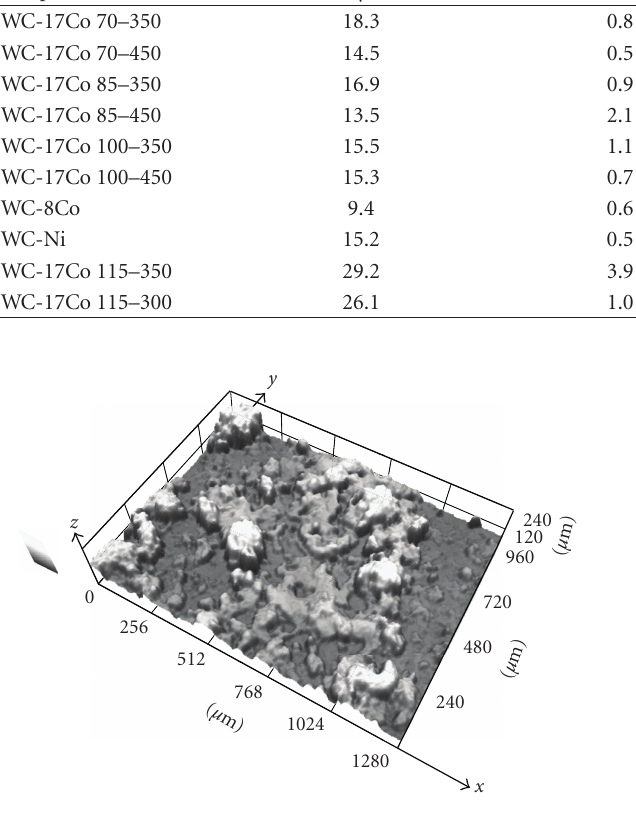
Figure 9: Reconstructed 3D of WC-Ni coating as-sprayed surface; laser confocal